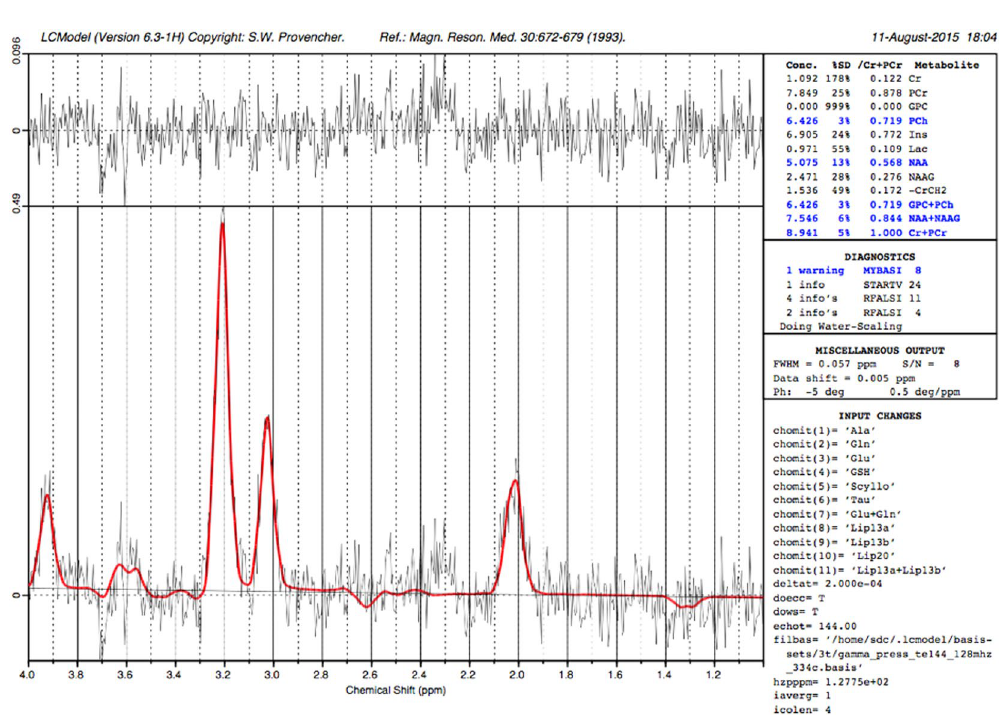
Figure 1. Example of a single 1 H-MRS voxel placed in the middle of the cerebellum on corresponding sagittal, coronal and axial T2 images.